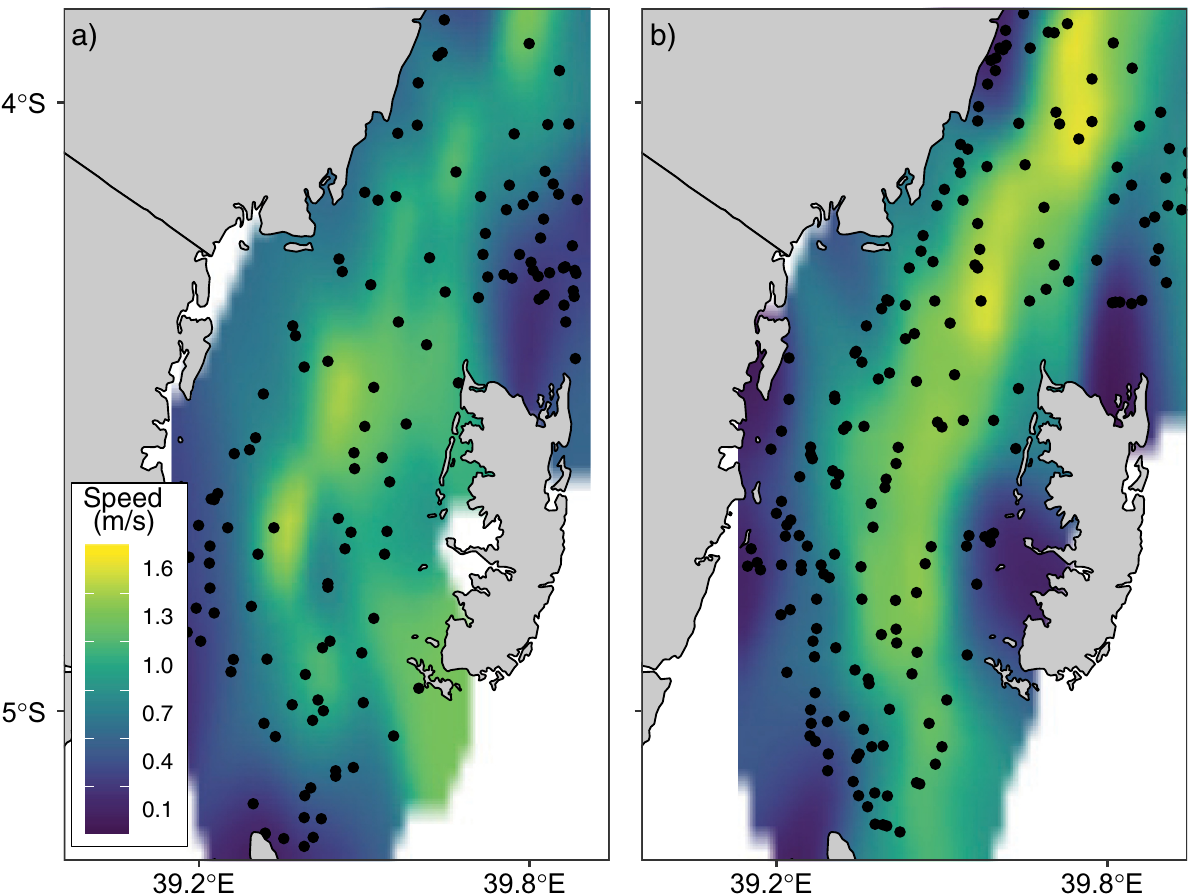
Fig 10. Spatial pattern of surface current velocities in the Pemba Channel during a) NE and b) SE monsoon seasons. Drifter observations are overlaid as circular points.